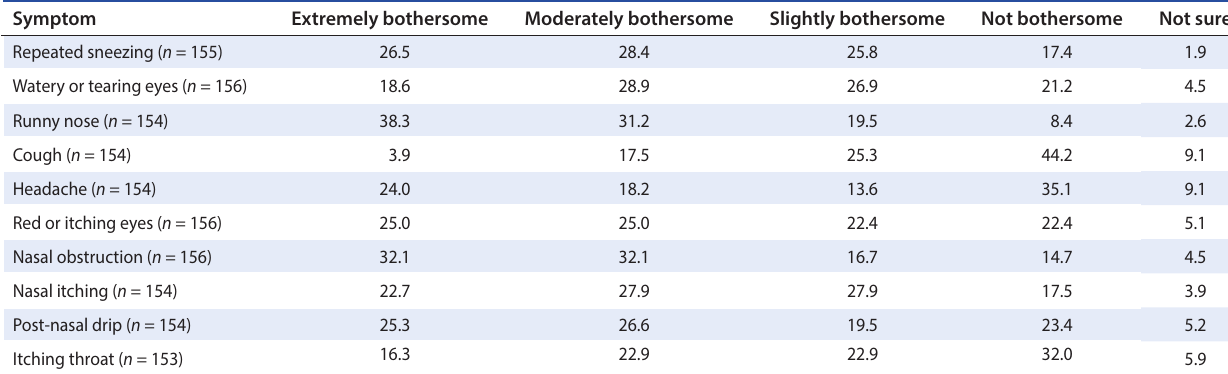
Table 2: The extent to which the symptoms are bothersome (%) Symptom Extremely bothersome Moderately bothersome Slightly bothersome Not bothersome Not sure Repeated sneezing ( n = 155) Watery or tearing eyes ( n = 156)